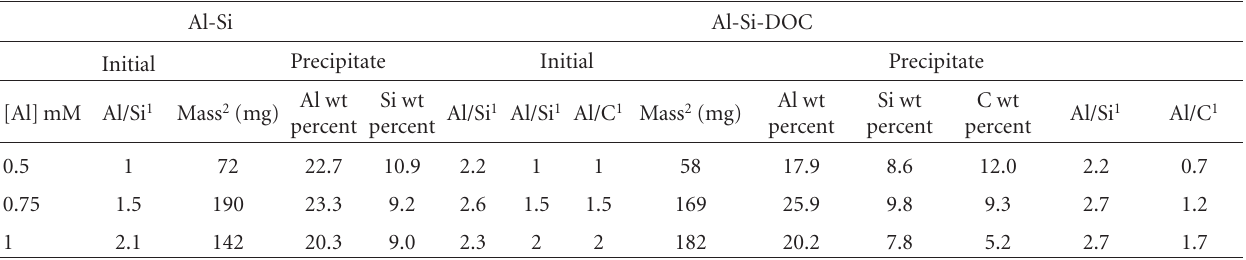
Table 3: Composition of precipitates derived from solutions with initial 0.5, 0.75, and 1.0 mM initial Al; 0.5mM initial Si and 0 or 0.5 mM (6mg/L)